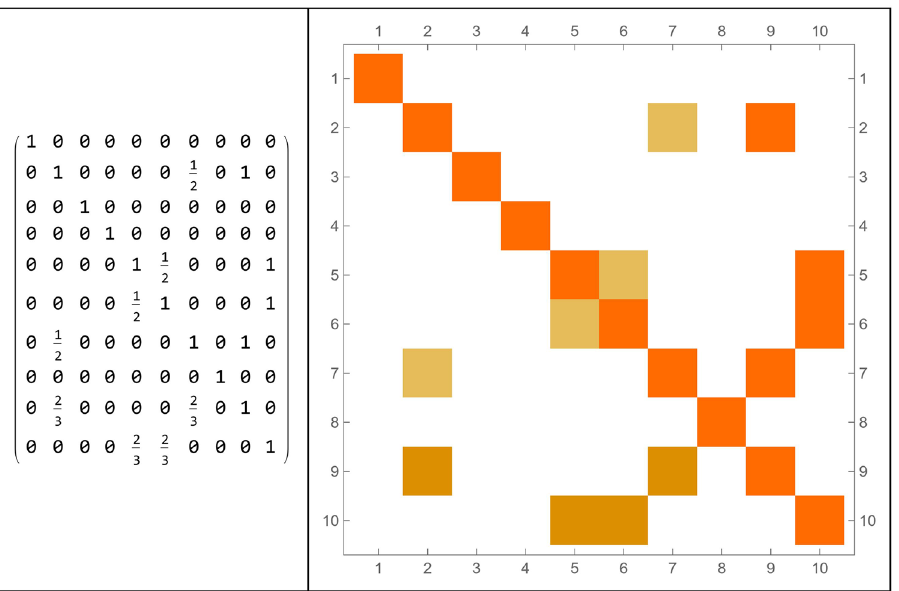
Figure 9. Intersection array and correlation matrix for representing relationships among the emerged